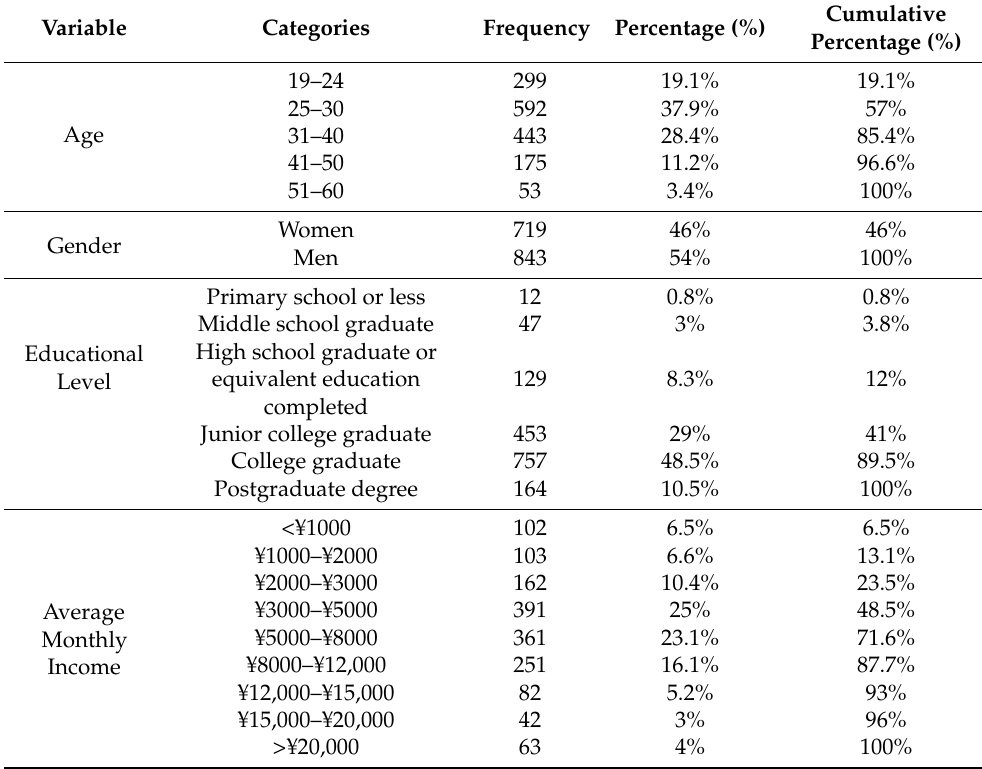
Table 1. Demographic characteristics of our study participants ( n = 1562).